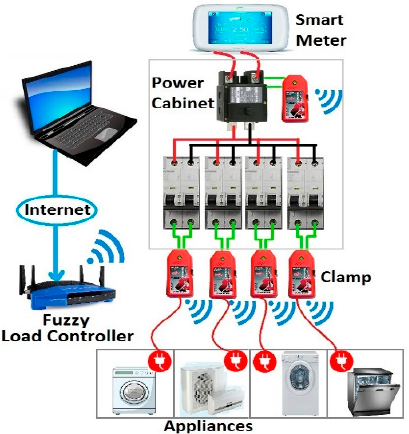
Figure 8. Architecture of the proposed Home Energy Management System (HEMS).